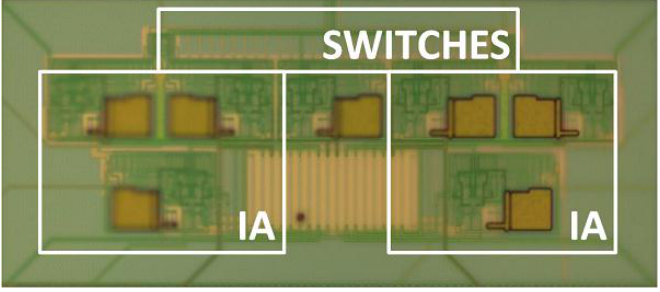
Figure 5. Integrated lock-in amplifier (detail) for the prototype, with an active area of 306 × 114 μm 2 . It includes the switches and instrumentation amplifiers